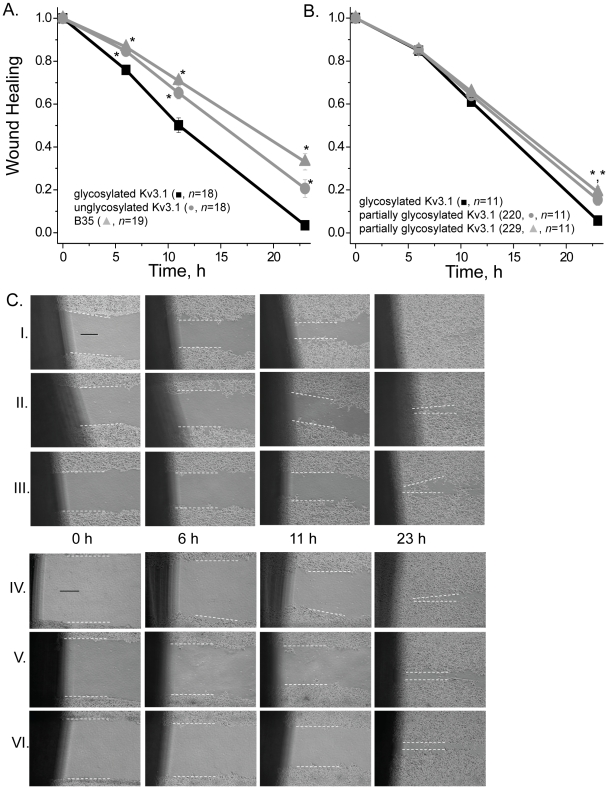
Kv3.1 protein associated with N-glycans enhances neuronal cell migration.Wound width was determined and then normalized at 0, 6, 11 and 23 h for glycosylated and unglycosylated Kv3.1 transfected and non-transfected B35 cells (A). Similar experiments were also performed for glycosylated, and partially glycosylated Kv3.1 glycoproteins (N220Q, and N229Q) transfected B35 cells (B). Data were expressed as the mean +/− SEM. Asterisks indicate significant differences in mean values at a probability of P<0.01 from that of glycosylated Kv3.1. Images were obtained at 0 h, 6 h, 11 h and 23 h of the generated wound for group I: wild type Kv3.1 (row I), N220Q/N229Q (row II) transfected B35 cells and non-transfected B35 cells (row III); and group II: wild type Kv3.1 (row IV), N220Q (row V) and N229Q (row VI) (C). The distance between the two white dashed lines represents wound width for each image. This distance becomes smaller as time increases, representing the rate of cell migration. n represents number of cell wounds. The experiments were conducted on three separate occasions. The solid black line represents a 25 µM scale bar.